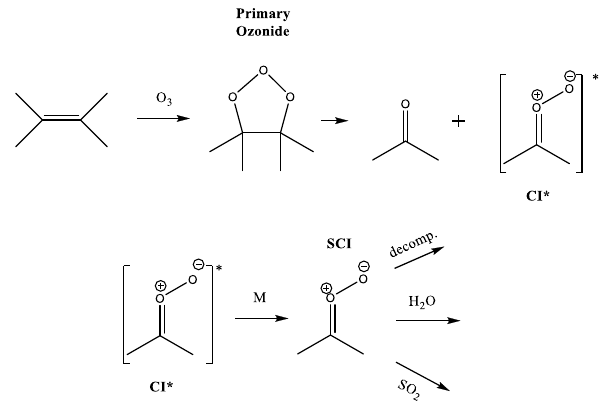
Scheme 1. Simplified generic mechanism for the reaction of Criegee intermediates (CIs) formed from alkene